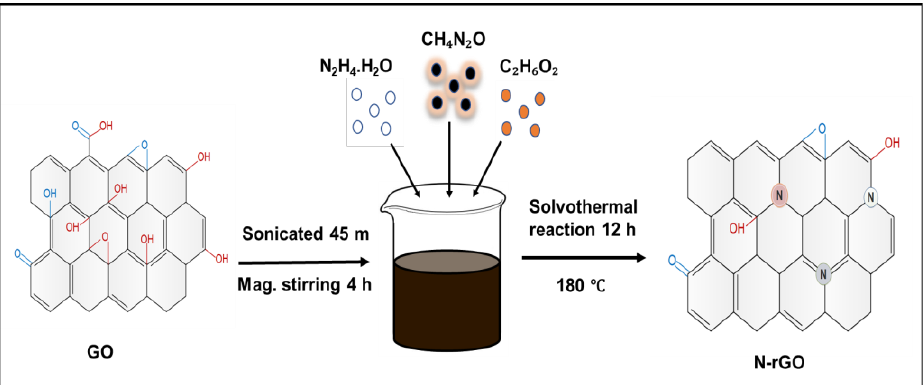
Figure 1. The illustrative layout depicts the procedure to prepare N-rGO nanoparticles.